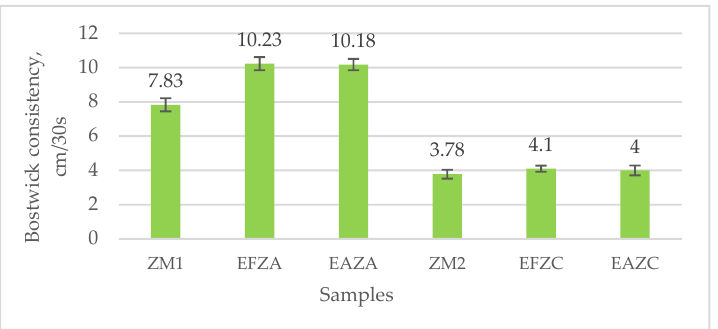
Figure 3. Bostwick consistency (cm/30 s) of zucchini purees enriched with anise/fennel aqueous extract, processed by steam and hot air convection. ZM 1 and ZM 2 are zucchini purees treated by steam convection and hot air convection, respectively; EFZA and EAZA are zucchini purees mixed with fennel or anise aqueous extract, processed by steam convection; EFZC and EAZC are zucchini purees mixed with fennel or anise aqueous extract, treated by hot air convection.